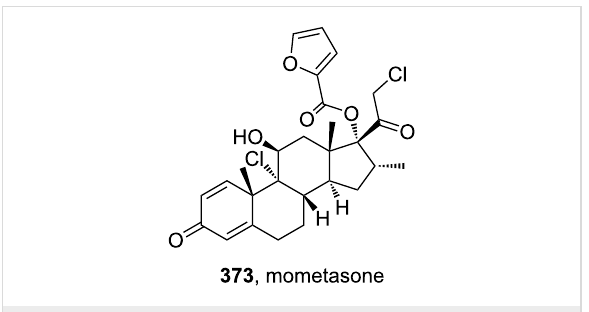
Figure 12: Structure of mometasone.